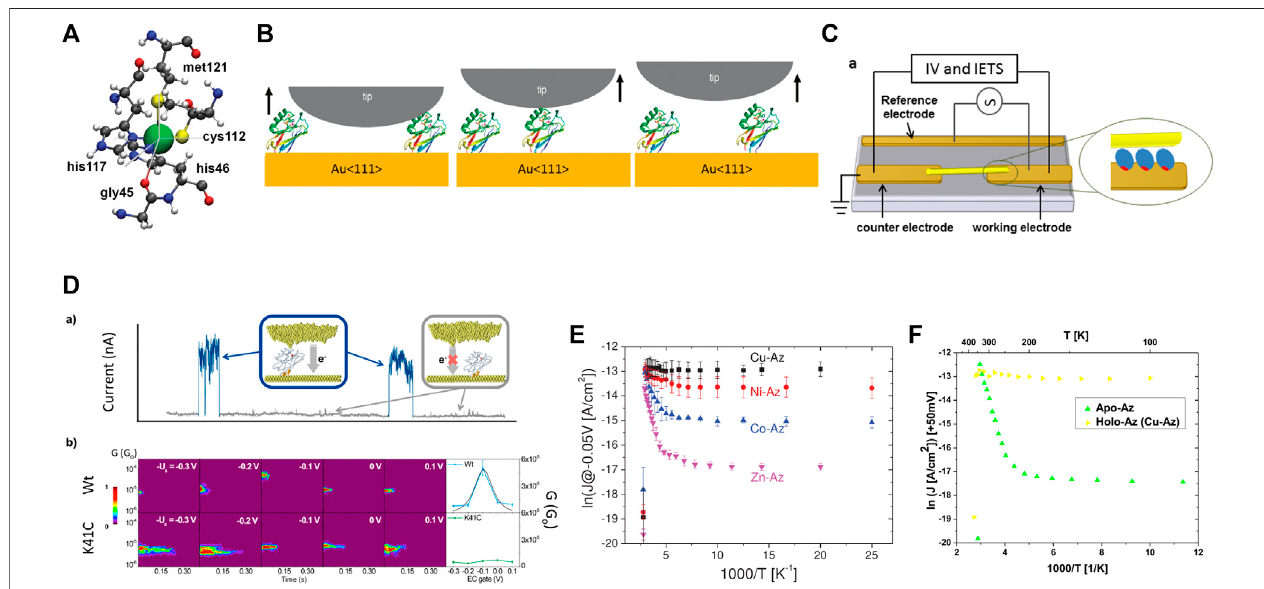
FIGURE 1 | (A) First coordination sphere of the Cu complex [56]; (B) Schemes of a single-azurin junction formation by the STM-BJ approach [24]; (C) Scheme of the Azurin junction fabricated by trapping nanowires by an ac electric fi eld [26]; (D) Representative “ blinks ” (blue traces) identi fi ed in the transients of the current fl owing between the two electrodes at a constant distance (upper panel) and Semilog 2D-blinking maps for the wild type blue-copper azurin (Wt) and K41C mutant at different EC gate potentials (lowerpanel) [38]; (E) ln(J) versus1,000/ T ofCu-Az,Ni-Az, Co-Az, and Zn-Az at − 50 mV bias[42]; (F) Experimental ln(J) versus1,000/ T of Apo- and Holo-Az junction at +50 mV bias